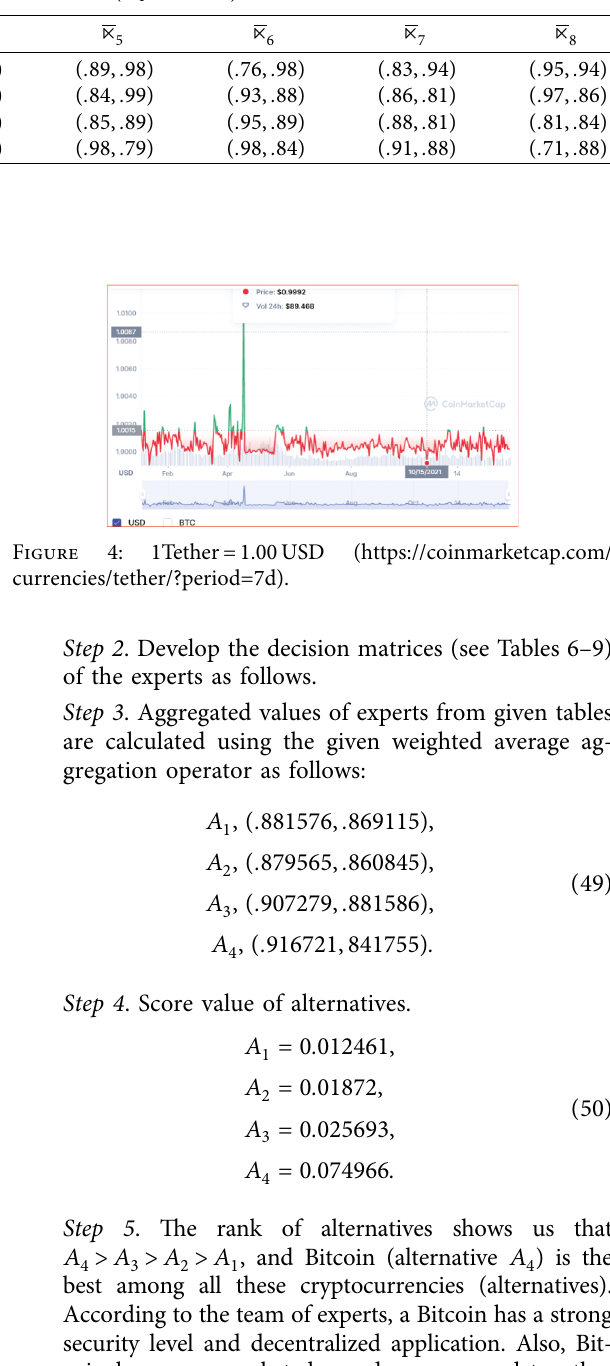
Table 9: Decision matrix for alternative ( A